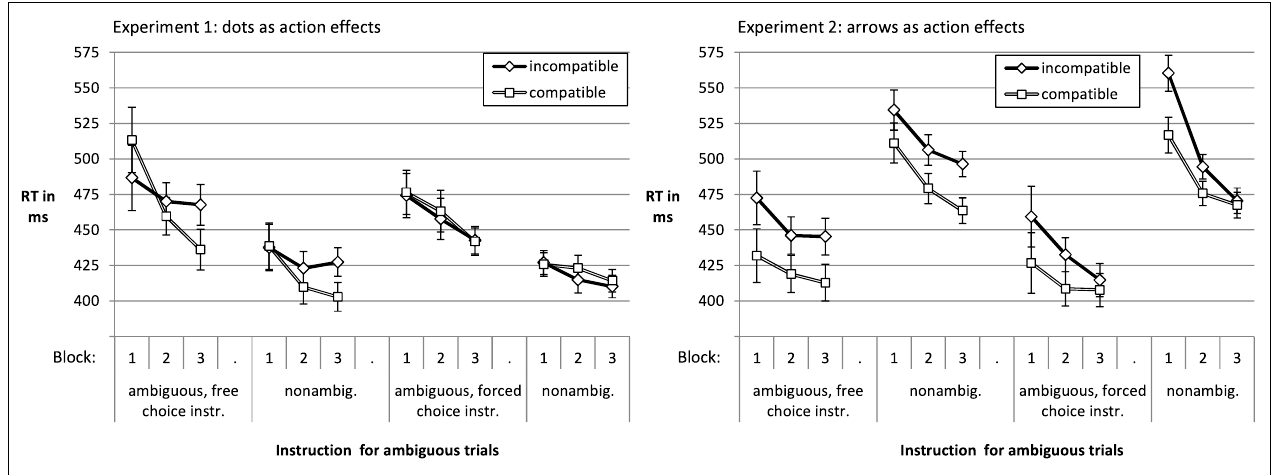
FIGURE 2 | Reaction times per block and condition in Experiments 1 and 2. The error bars in this and all other graphs reflect ± the standard error of the compatibility effect at each factor level of the other factors.